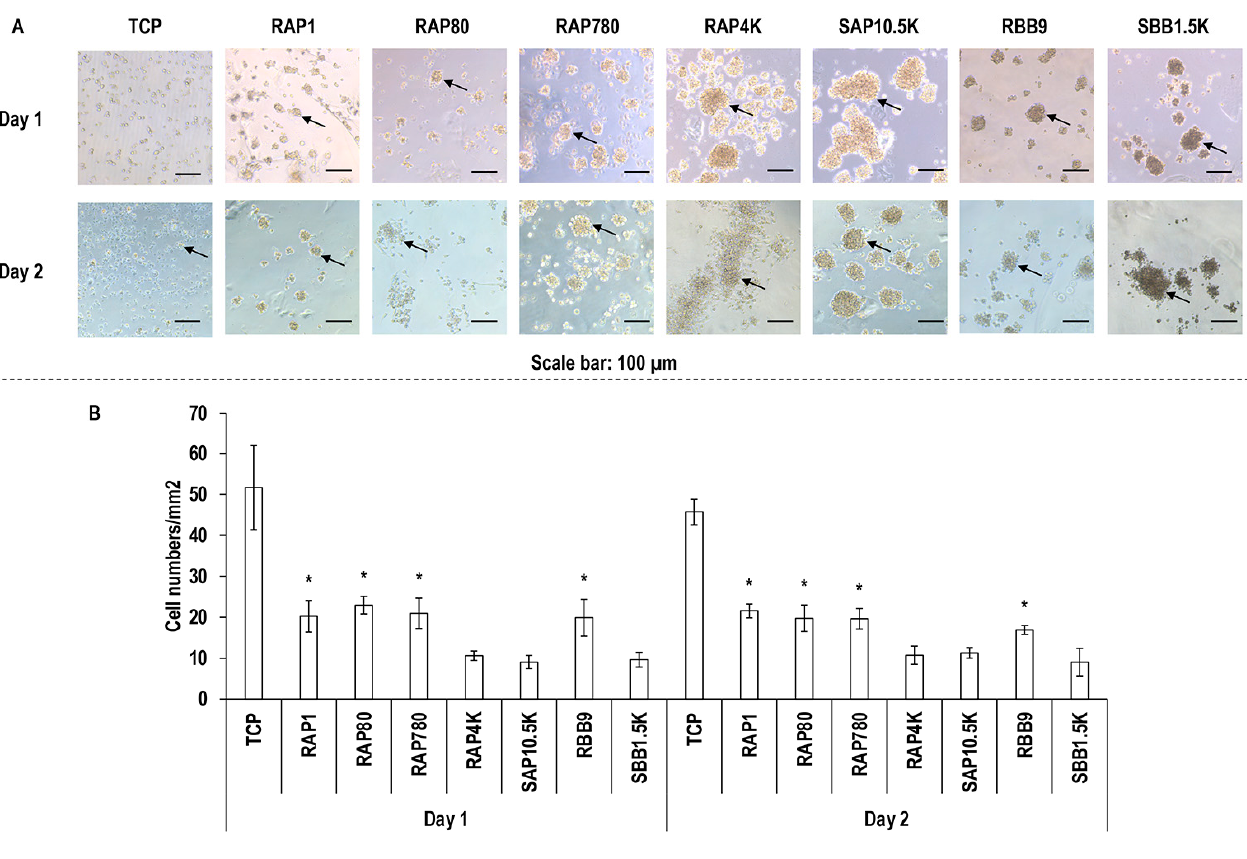
Figure 4. Macrophage morphology ( A ) and cell number ( B ) analyses. Cell clusters are indicated using black arrows. TCP: Tissue culture plastic. *: Indicates statistically significant difference ( p < 0.005) between the gelatin samples used in this study at a given timepoint.